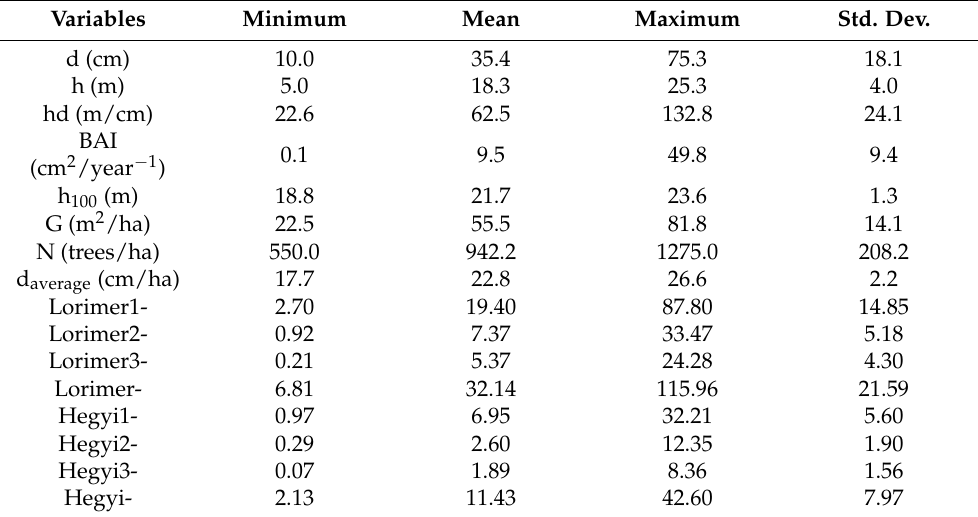
Table 4. Descriptive statistics for measured variables of A. angustifolia in a Mixed Ombrophilous Forest in Southern